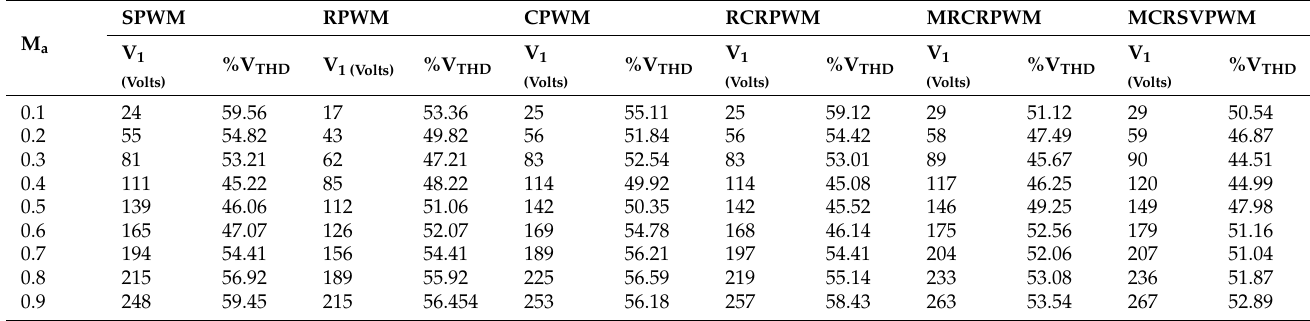
Table 4. Simulation study results comparing the line voltage and line voltage THD for the proposed MCRSVPWM with the other reported RPWM